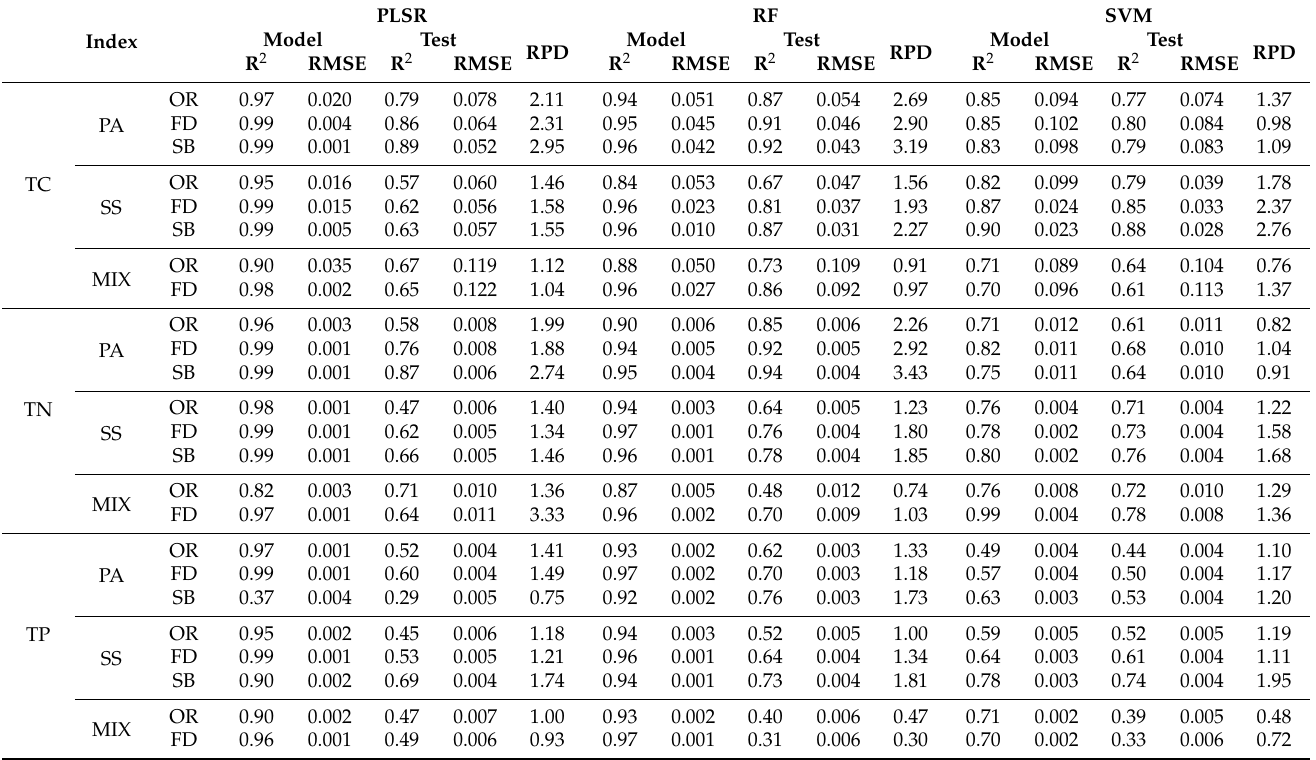
Table 1. Accuracy of the prediction models for P. australis (PA) and S. salsa (SS) total carbon (TC), total nitrogen (TN), and total phosphorus